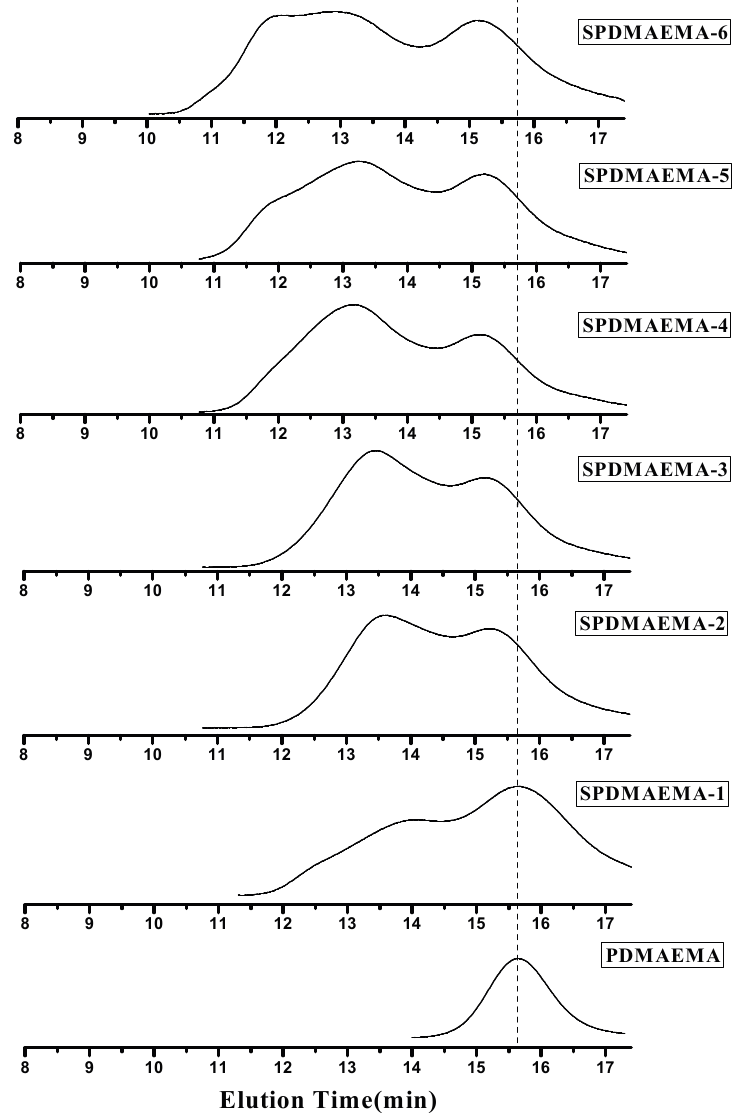
Figure 3. Gel permeation chromatograph (GPC) traces of SPDMAEMA with the DVB/PDMAEMA-CPTCD = (SPDMAEMA-3); 45(SPDMAEMA-4); 50 (SPDMAEMA-5); 55 (SPDMAEMA-6) obtained for 12 h polymerization at 100 °C in the presence of AIBN as initiator (molar ratio: PDMAEMA-CPTCD/AIBN = 1:0.5), PDMAEMA-CPTCD: 0.4150 g, Toluene: 8.26